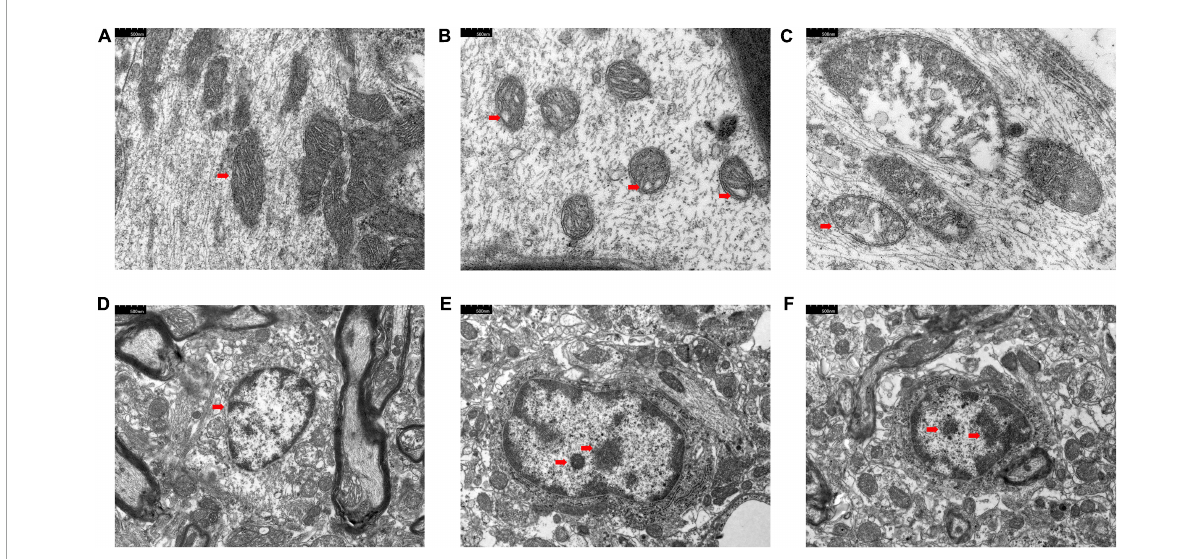
FIGURE2 Electron microscopy results of DRG and SDH. Sham group ( n = 3); model group ( n = 3); tuina group ( n = 3). Panels (A–C) were DRG; the arrow showed the mitochondrial vacuoles; panels (D–F) were SDH; the arrow shows the chromatin aggregation. (A,D) Sham group; (B,E) Model group; (C,F) Tuina group.